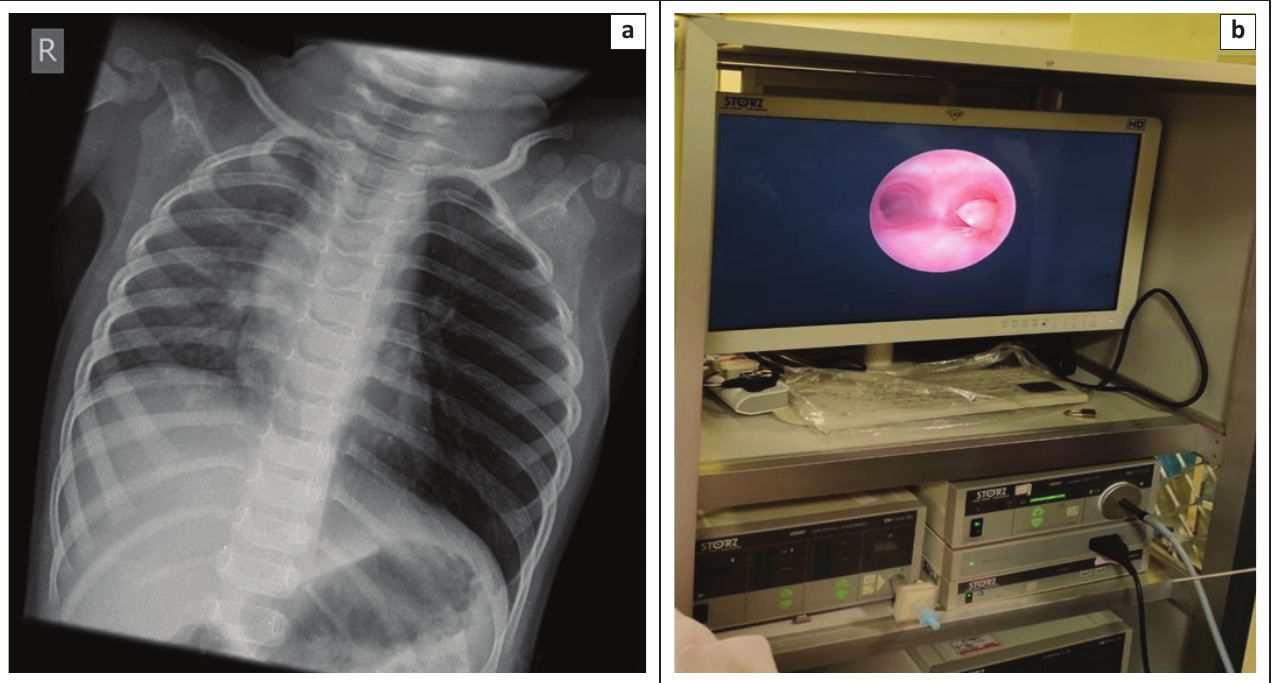
FIGURE 13: Chest radiograph (a) of a 2-year-old child who aspirated a peanut into the left main bronchus with resultant air trapping and hyperinflation of the left lung. Bronchoscopy (b) confirmed the aspirated peanut in the left main